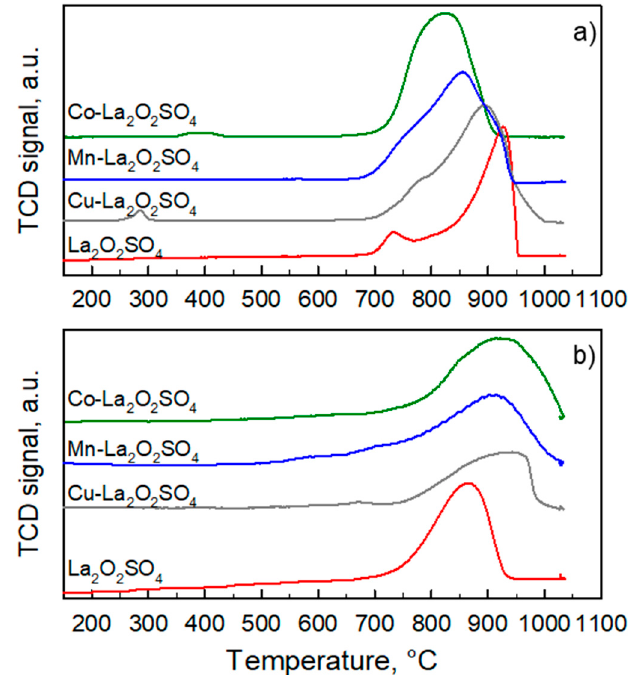
Figure 3. ( a ) H 2 -TPR profiles of La 2 O 2 SO 4 and metal (Cu, Mn, Co) promoted La 2 O 2 SO 4 ; ( b ) O 2 -TPO profiles recorded during the subsequent re-oxidation of OC materials. Heating 10°C/min from room temperature up to 1030 °C.